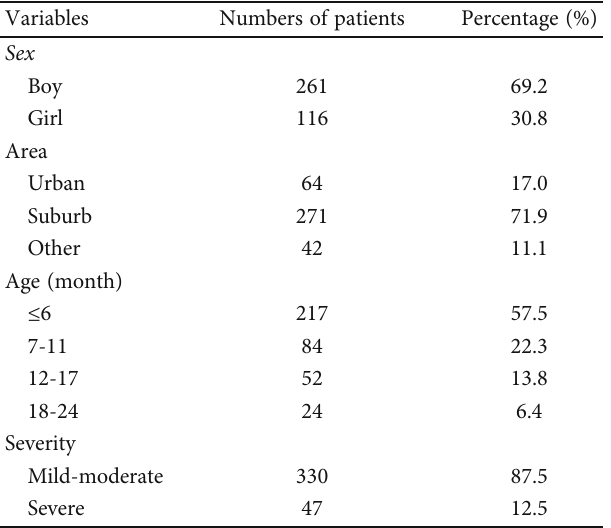
Table 2: Epidemiological characteristics of children with acute bronchiolitis caused by RSV ( N = 377